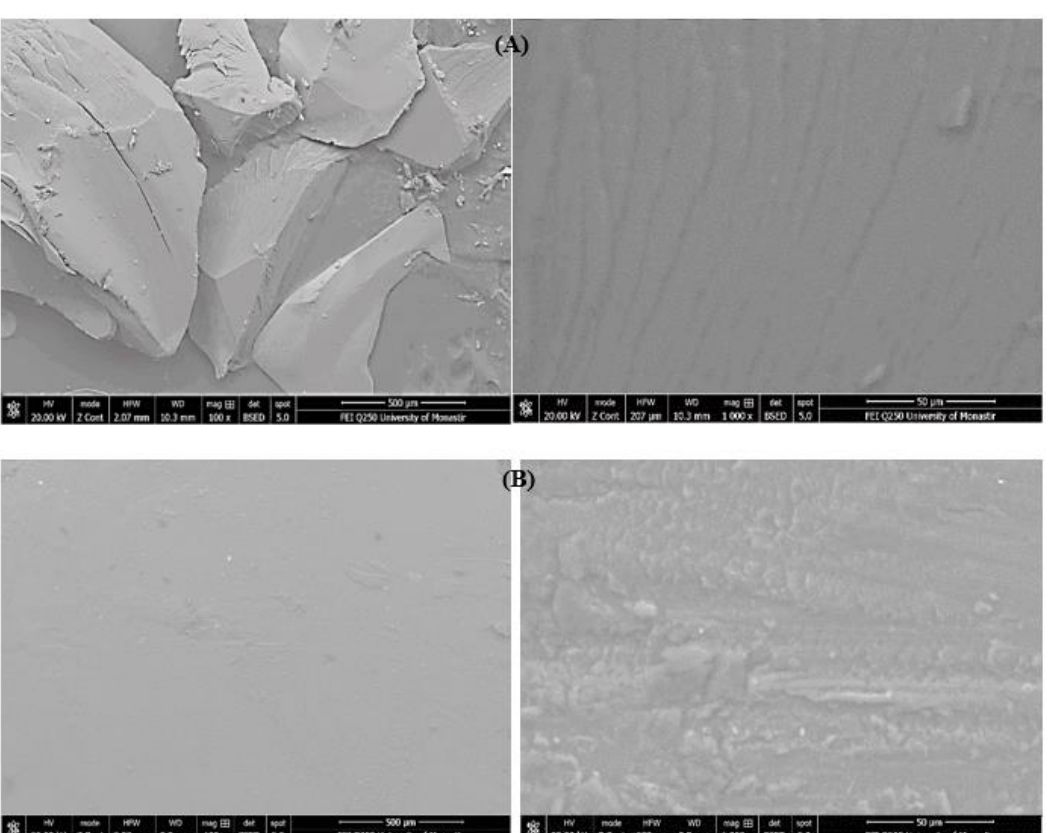
Figure 3. Morphological pictures of: ( A ) pectin beads and ( B ) pectin-[Sb(TPP)Cl 2 ] composite beads (1%).